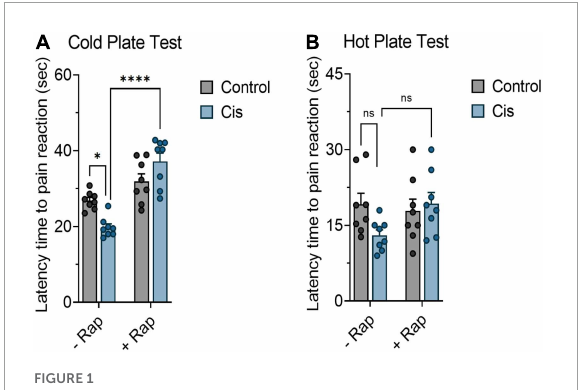
FIGURE1 Effect of rapamycin on thermal hypersensitivity induced by chronic exposure to cisplatin. Balb/c mice were treated with cisplatin 3 mg/kg (i.p.) with or without rapamycin 3 mg/kg (s.c.) every other day for 12 days. (A) Impact of rapamycin on cisplatin using cold plate test. (B) Impact of rapamycin on cisplatin using hot plate test. ∗ p < 0.05, ∗∗ p < 0.01, ∗∗∗ p < 0.001, and ∗∗∗∗ p < 0.0001 indicates statistical significance between treatment groups (two-way ANOVA followed by Tukey’s post-hoc test; n = 8 mice). ns, non-significant.